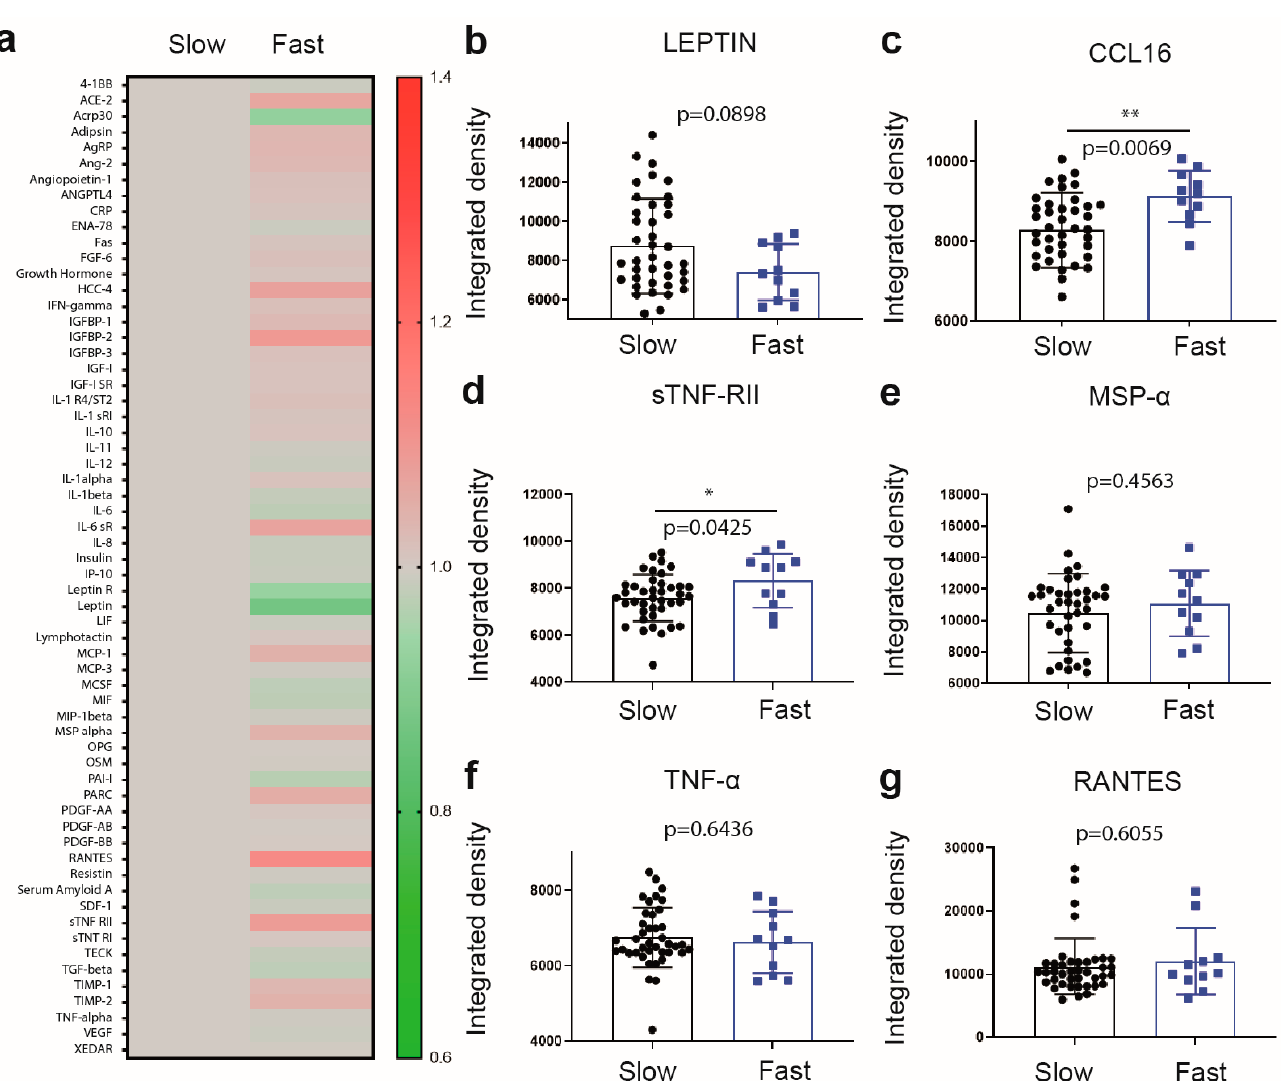
Figure 2. Cytokines/adipokines/chemokines profile in fast progressing ALS. ( a ) Heat map illustrating cytokines changes (ratio) in fast progressing ALS patients (11) as compared to slow progressing ALS patients (40) measured by cytokines array. ( b – g ) individual graph of cytokines with significant variations. Human Obesity Array is a semi-quantitative method with arbitrary measures (integrated density) (Data are mean ± SEM * p ≤ 0.05, ** p < 0.01,)